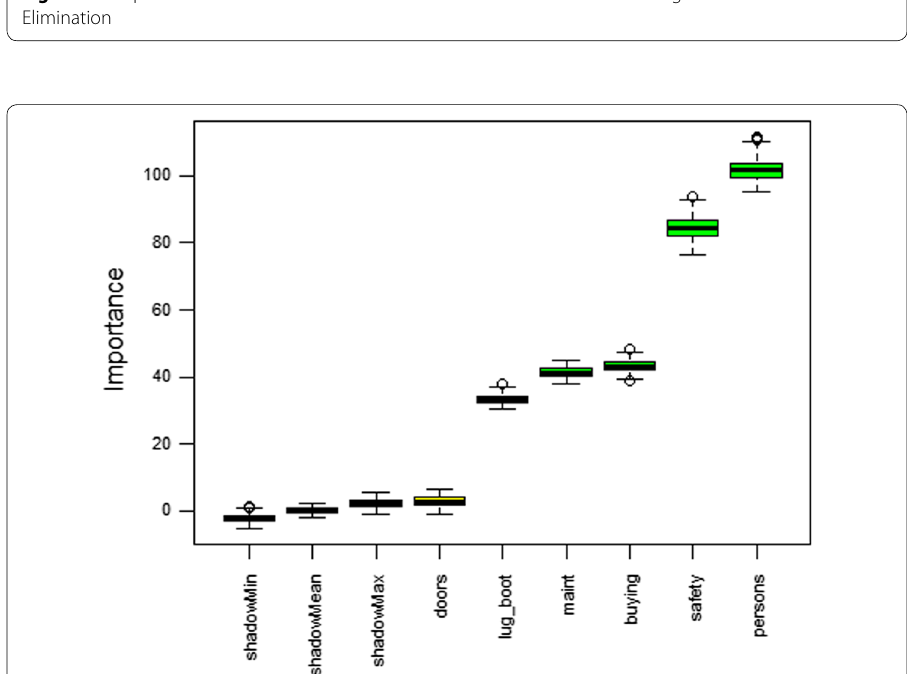
Fig. 8 The important measure for each variable of the Car Evaluation dataset using